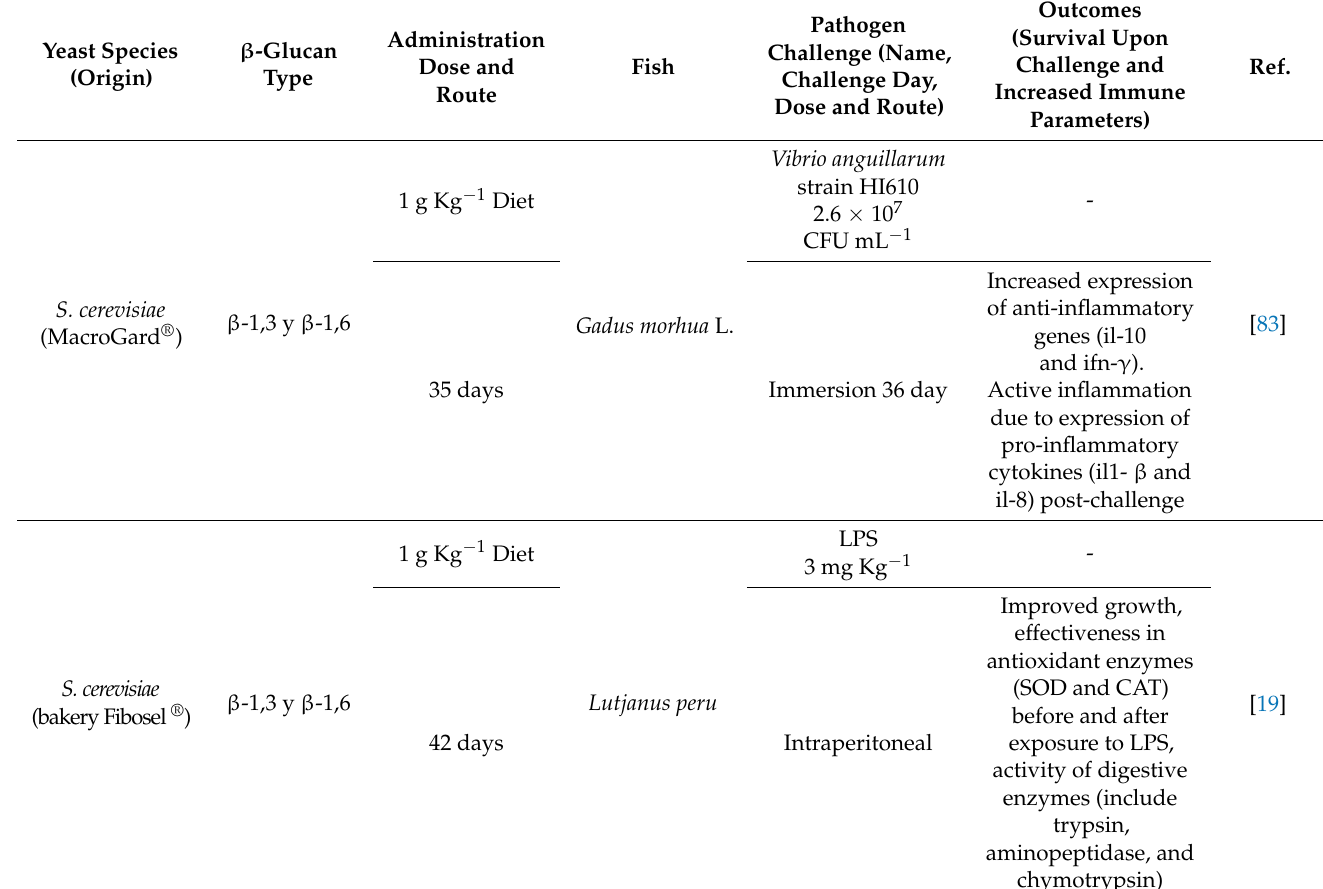
Table 3. In vivo effects of yeast β -glucans on the immune systems of different marine fish